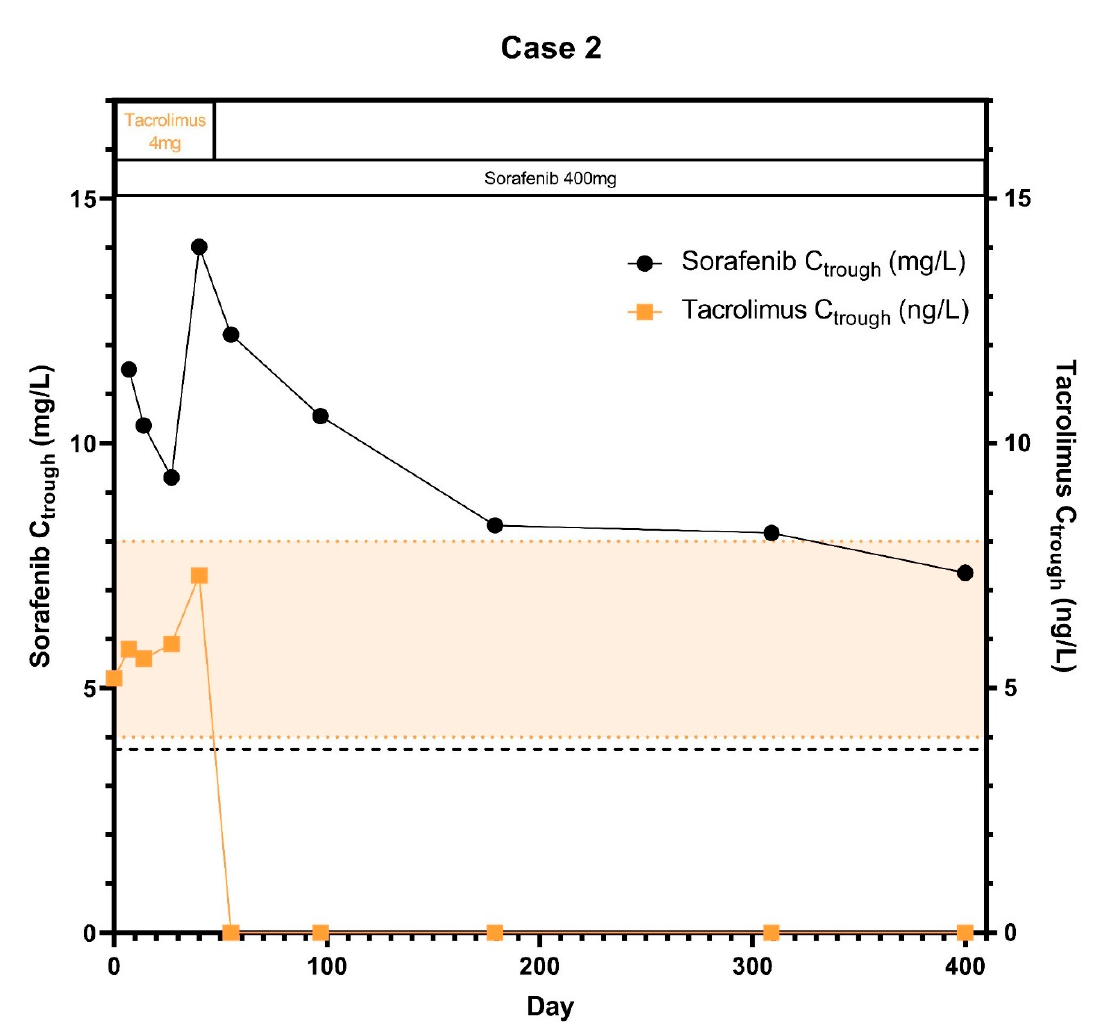
Figure 2. Sorafenib and tacrolimus C trough concentrations over time for Subject 2: The C trough levels over time after the start of sorafenib treatment. Furthermore the optimal C trough levels of both sorafenib and tacrolimus are